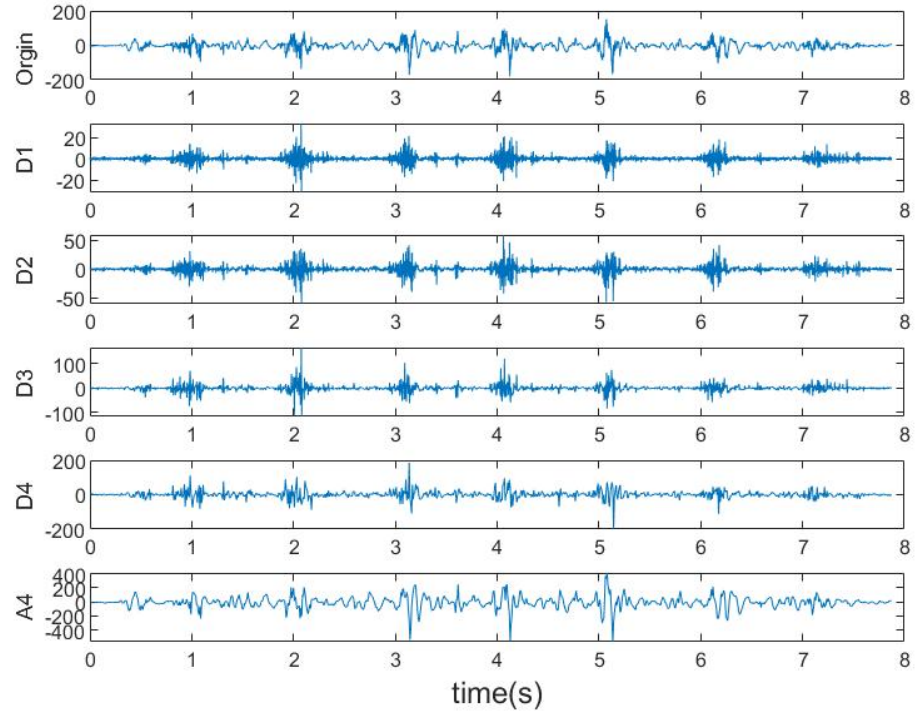
Figure 3. An example of wavelet decomposition of one sequence of LRF signal during walking. The selected TFD feature is Energy of Wavelet Coefficient (EWC), which is defined as the Energy of the final approximation and all four